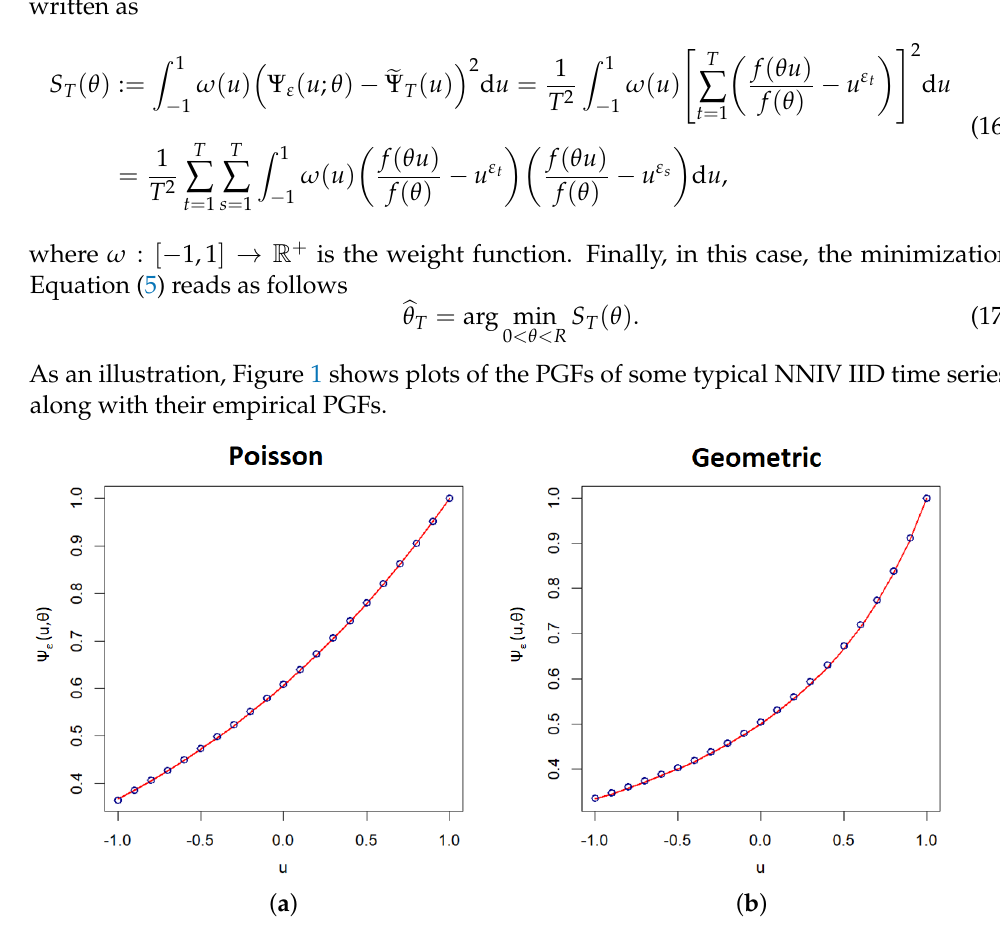
Figure 1. Graphs of PGFs (lines) and empirical PGFs (dots) of the IID series: ( a ) Poisson distribution; ( b ) geometric distribution. (True parameter value is θ =